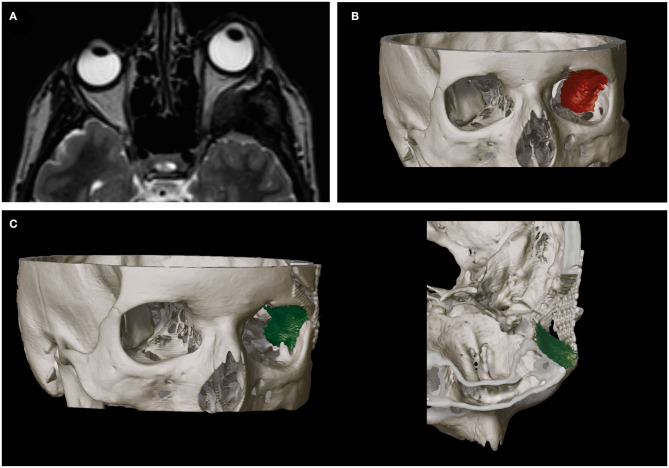
Orbital reconstruction after removal of hyperostotic lateral orbital bone enables restoring of physiological intraorbital anatomy. Illustration of preoperative proptosis of the left eyeball (A) as a result of meningioma-induced lateral orbital wall hyperostosis (red) (B). (C) Surgical reconstruction of the lateral orbital wall (green) yields removal of intraorbital space-occupying effects and restores intraorbital physiological topography (left, fronto-temporal view; right, cranial view).